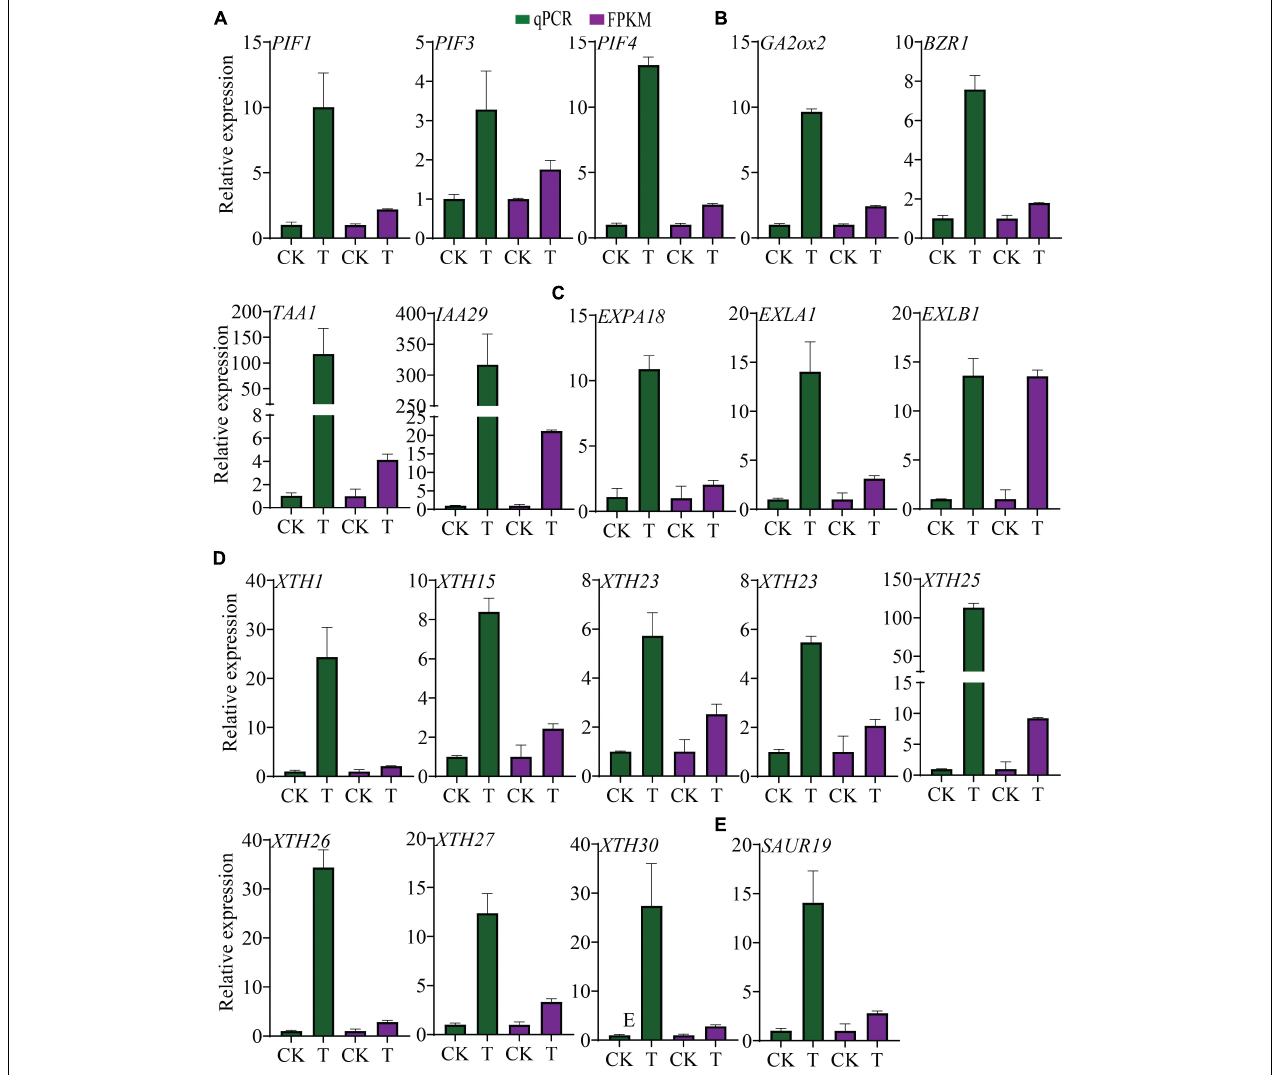
FIGURE 7 | Transcriptional alterations of PIFs, their putative target genes and hypocotyl and root growth-related DEGs. (A) Expression level of PIF1, -3, -4 in transgenic plants and control. (B) Expression of PIF putative direct target genes GA2ox2 , BZR1 and TAA1, and IAA29. (C) Transcript levels of expansins. (D) Transcript level of XTH s. (E) Transcript level of SAUR19 . The data were shown as mean ± standard deviation of three biological replicates, and 18srRNA was used as internal control for the normalization of expression